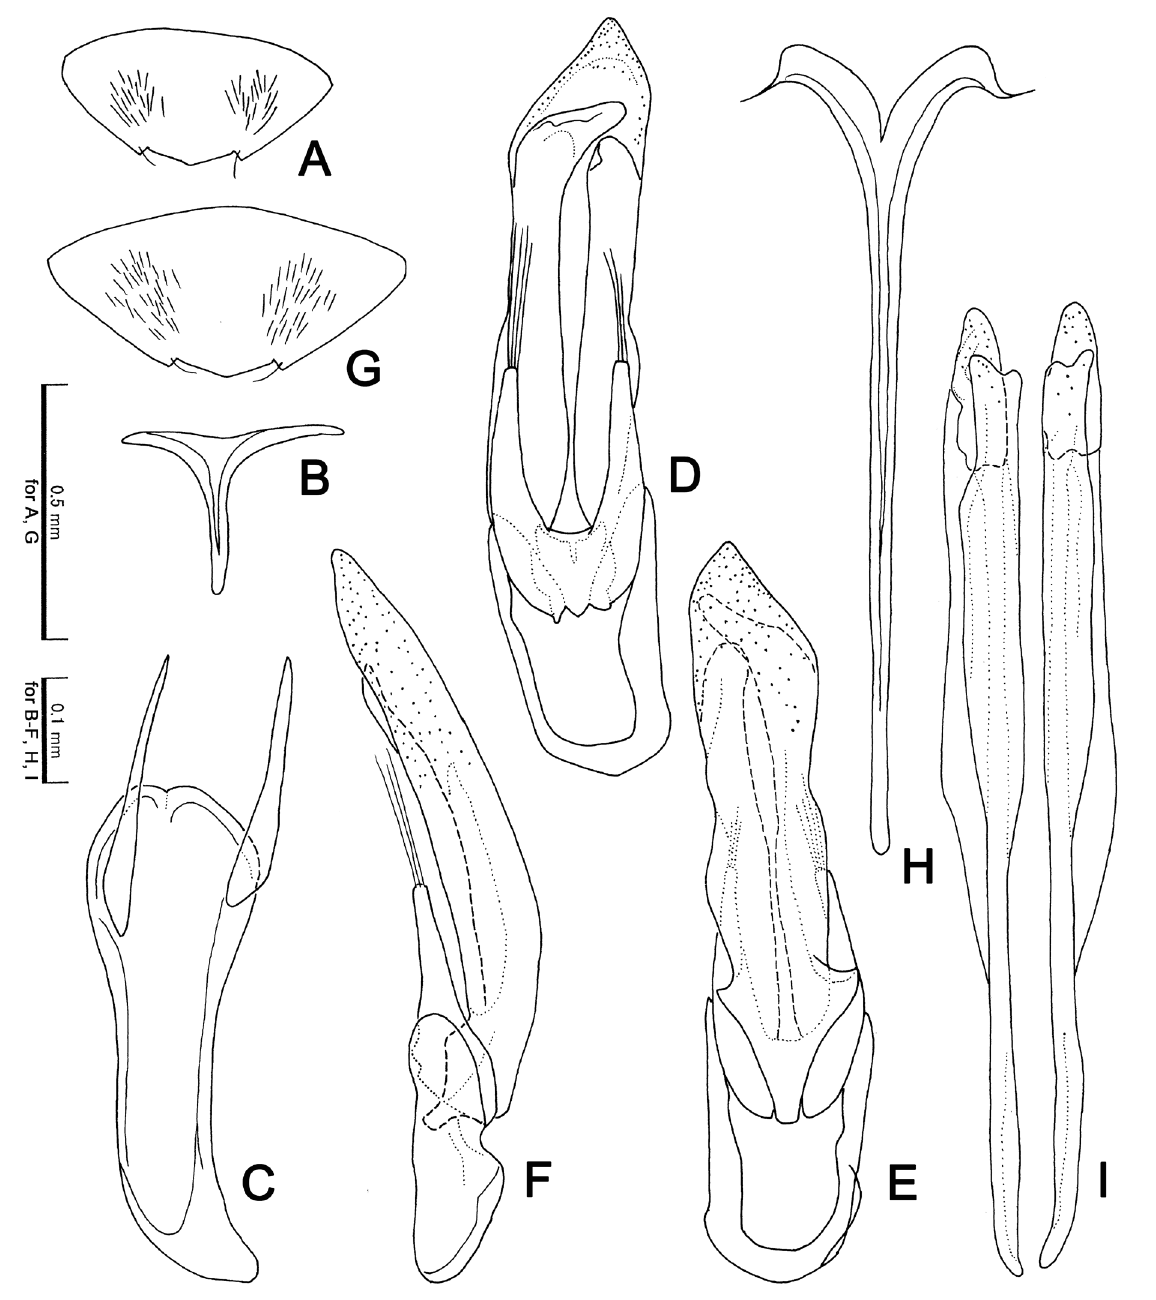
Fig. 18. Mexico masamii (Satô, 1994), m ale (A–F) and female (G–J) genitalia (EUMJ). A, G . Sternite VII. B . Sternite VIII. C . Sternite IX. D . Aedeagus, ventral view. E . Aedeagus in dorsal view. F . Aedeagus in right lateral view. H . Urosternite. I .